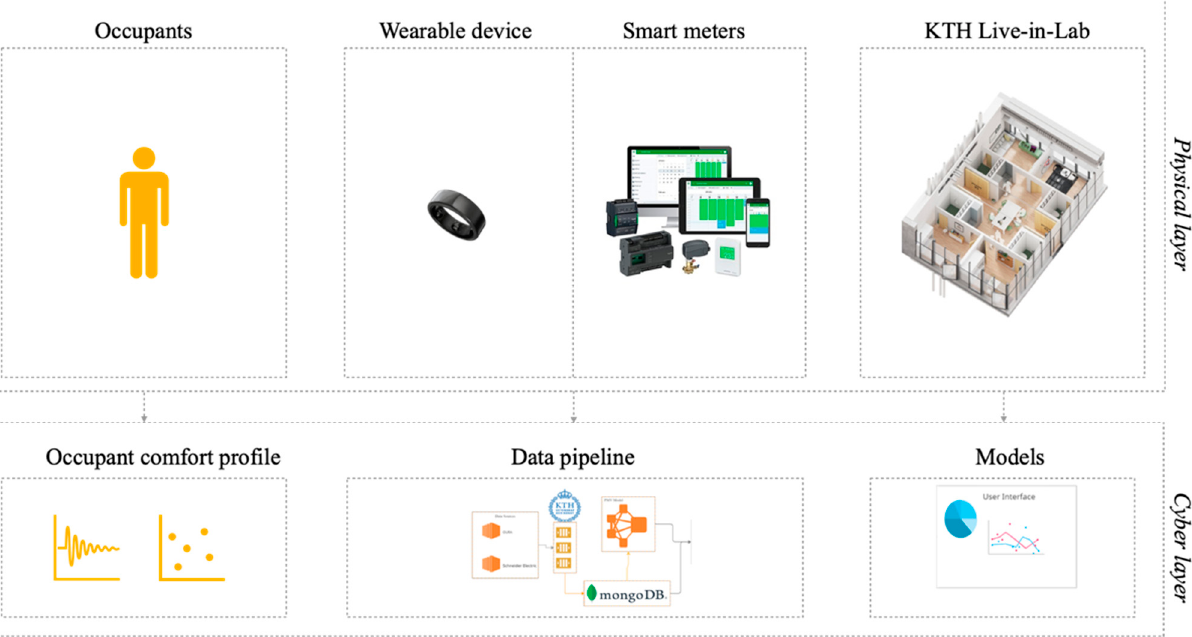
Figure 2. Study system boundaries.